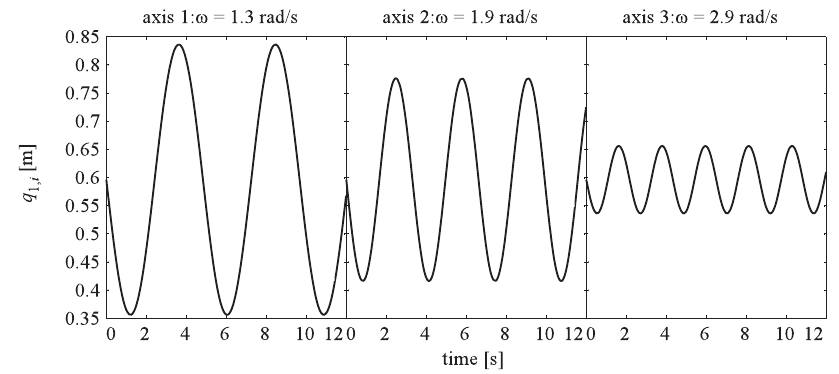
Figure 7. Harmonic displacement profiles used for model